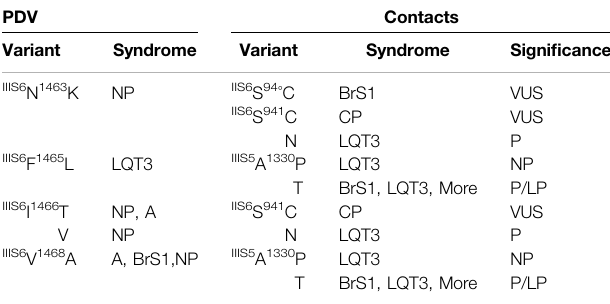
TABLE 2 | PDVs and their contact variants in the open-PD model a